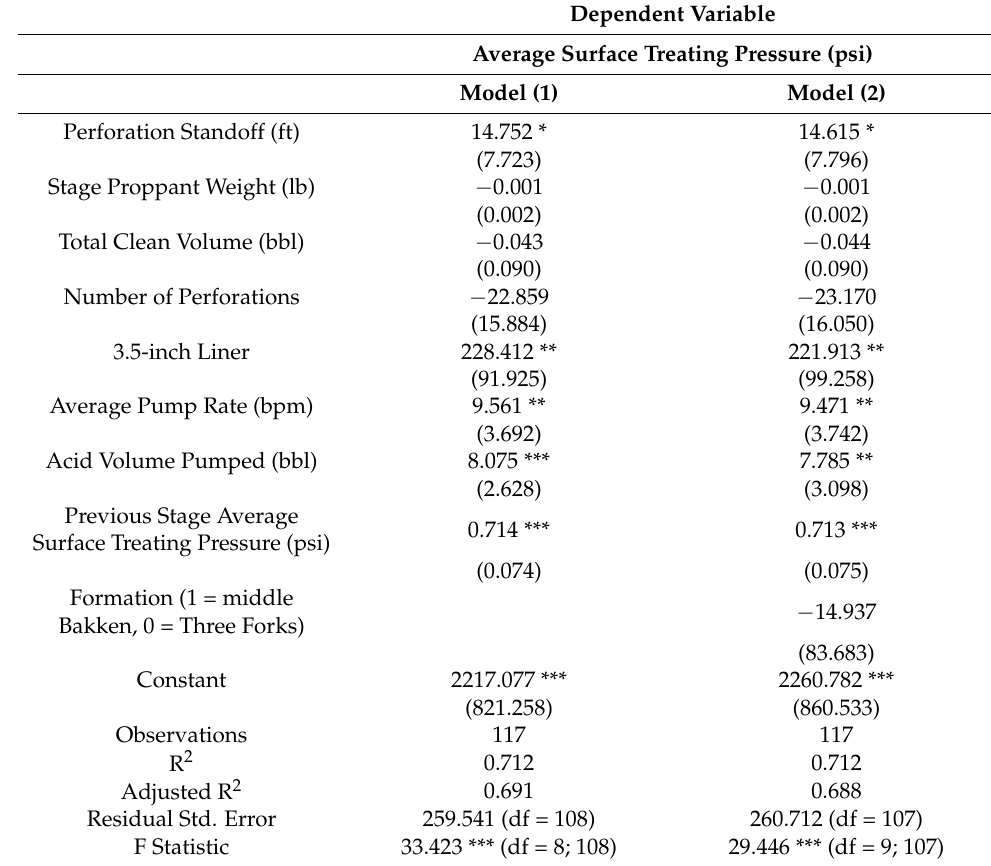
Table 3. Regression results showing two different